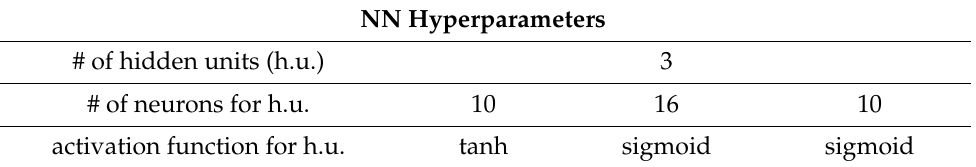
Table 1. Hyperparameters settings of the (fully connected) Multilayer Perceptron. NN Hyperparameters # of hidden units (h.u.) # of neurons for